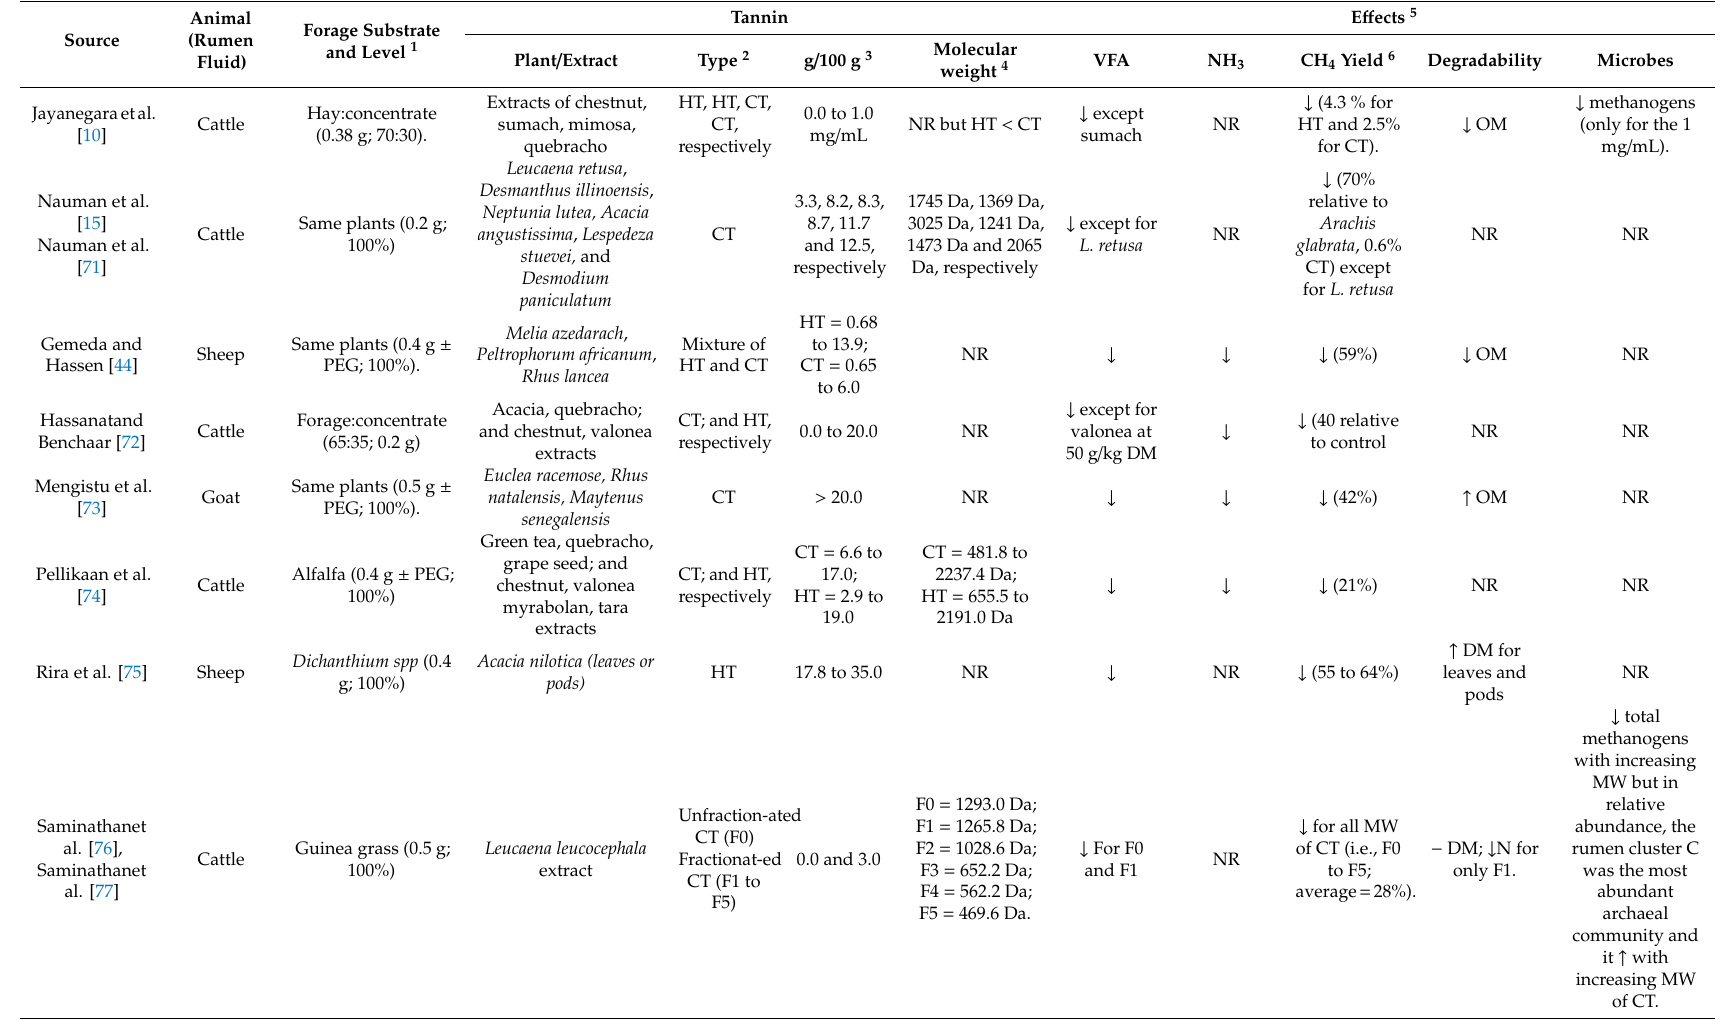
Table 3. Summary of tannin e ff ects on in vitro fermentation, degradability, microbes and enteric methane emission in